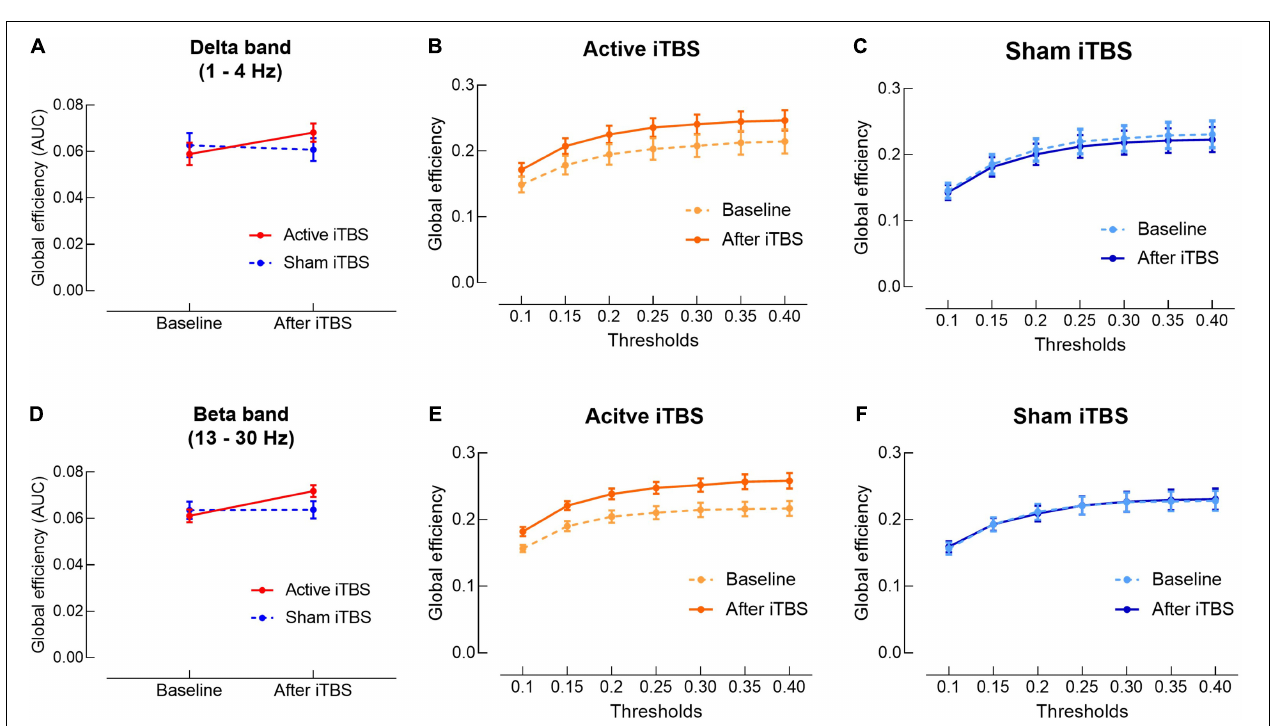
FIGURE 3 | Beta band interhemispheric functional connectivity change after iTBS. Beta band coherence between left and right sensorimotor cortices was significantly increased after Active or Sham iTBS in all subjects without significant group differences (A) . The topographies (B) and matrixes (C) represent z-scores of coherences between pairs of electrodes in the left and right sensorimotor cortices before and after iTBS in the Active and Sham iTBS groups. Warmer colors indicate greater coherence, while cooler colors indicate less coherence.